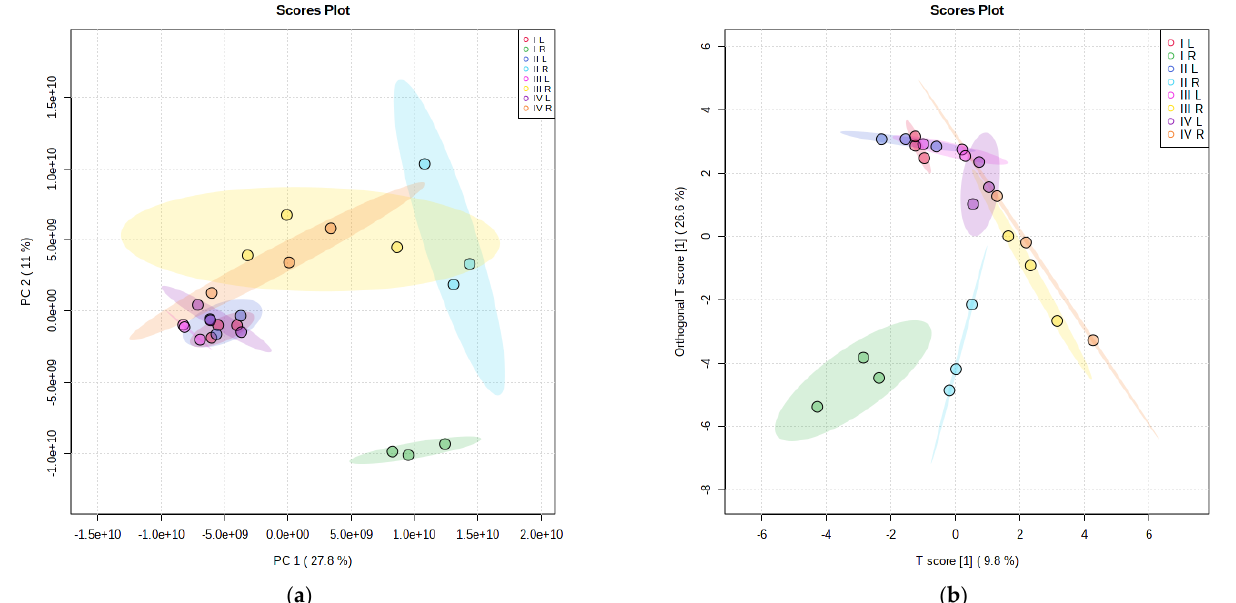
Figure 12. United PCA ( a ) and OPLSDA ( b ) analysis of metabolite network of biolayers from Ruskeala quarry and museum necropolises.